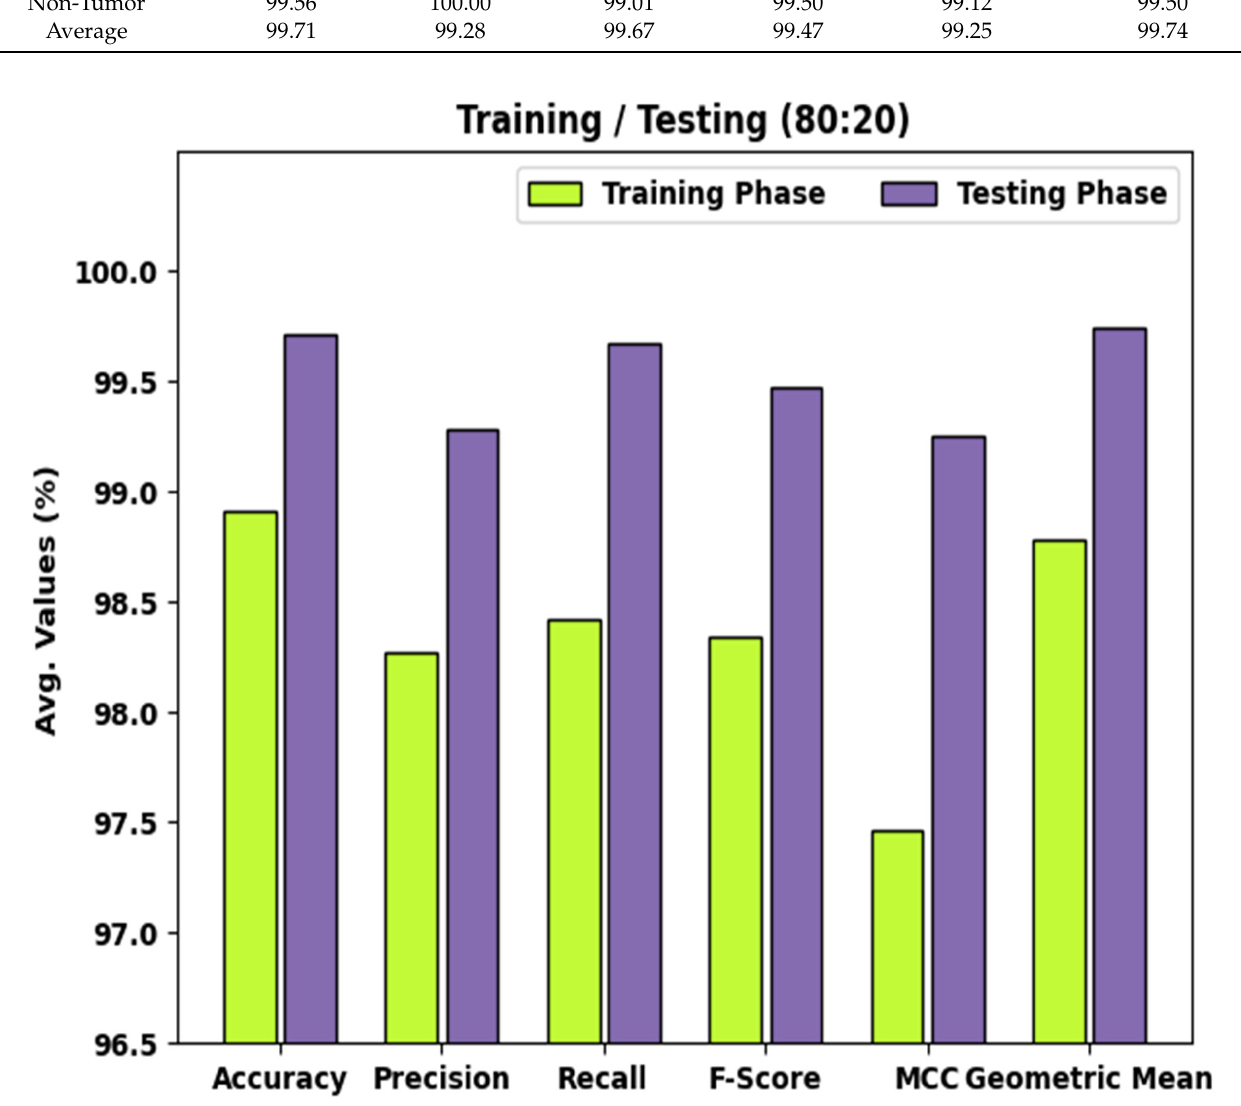
Figure 5. Result analysis of WDODTL-ODC technique under 80% of TR and 20% of TS data.